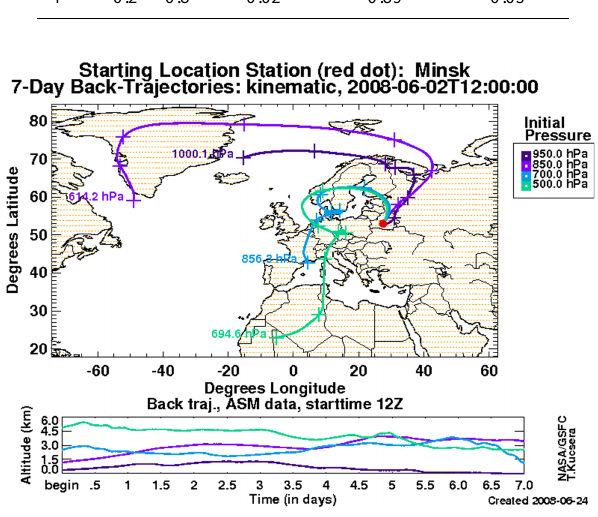
Fig. 12. Air mass back trajectories for the Minsk measurement site on 2 June 2008.